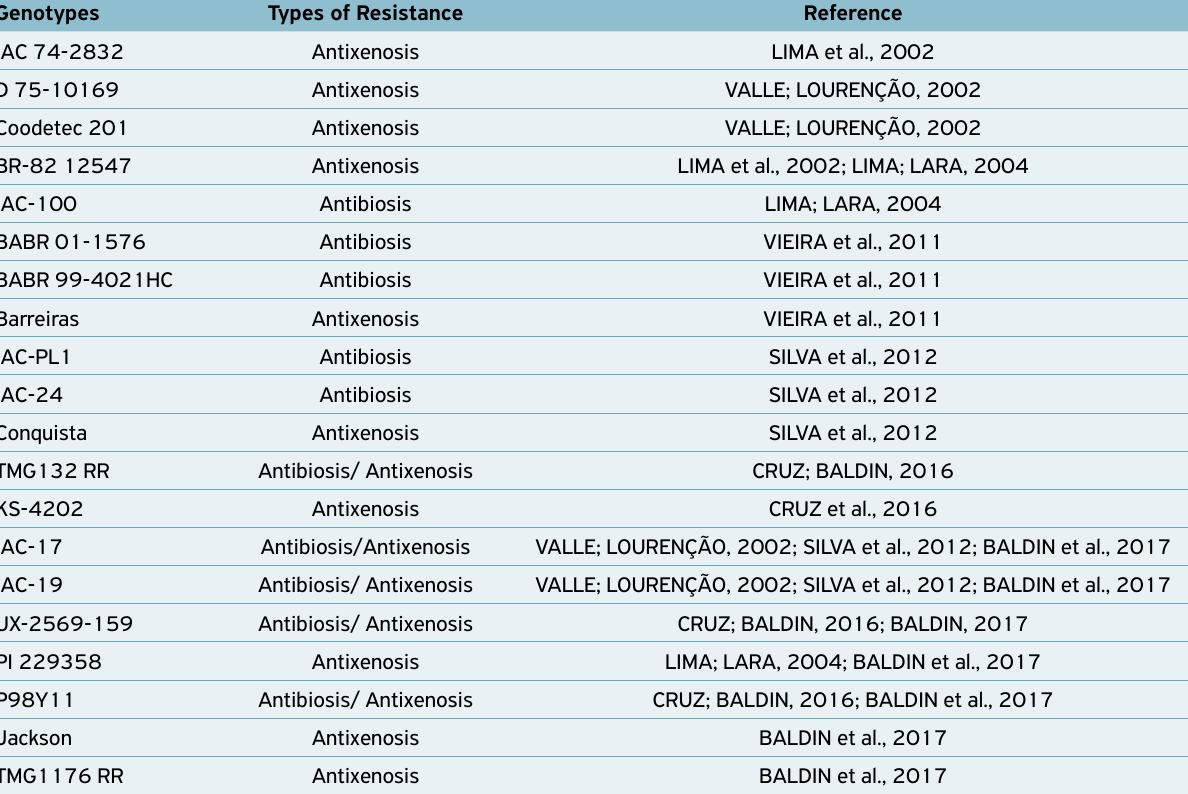
Table 1. Soybean genotypes evaluated regarding resistance types to Bemisia tabaci biotype